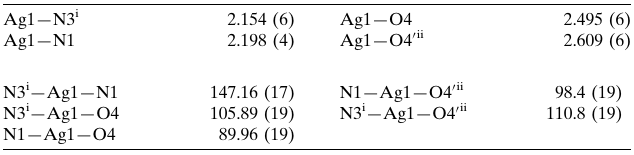
Selected geometric parameters (A˚ , (cid:2)